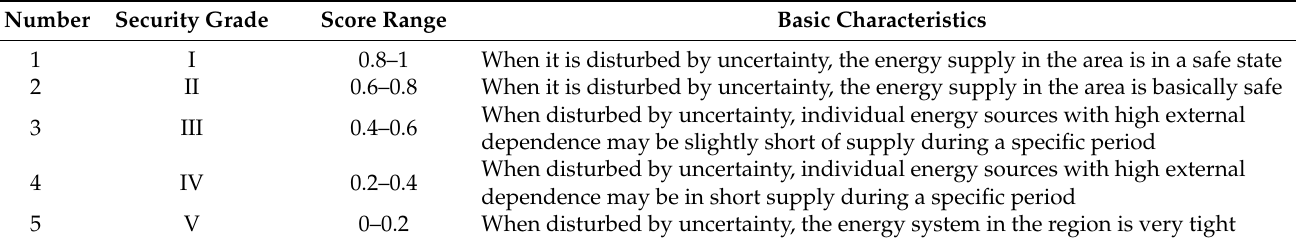
Table 2. Energy resilience level